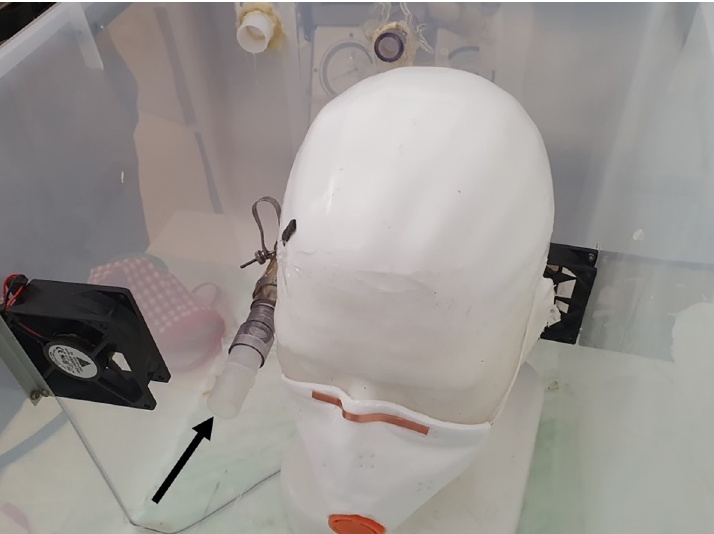
Fig 3. Measuring box. Photo from inside of the measuring box with the open pipe (arrow) and the mask attached to the phantom head.